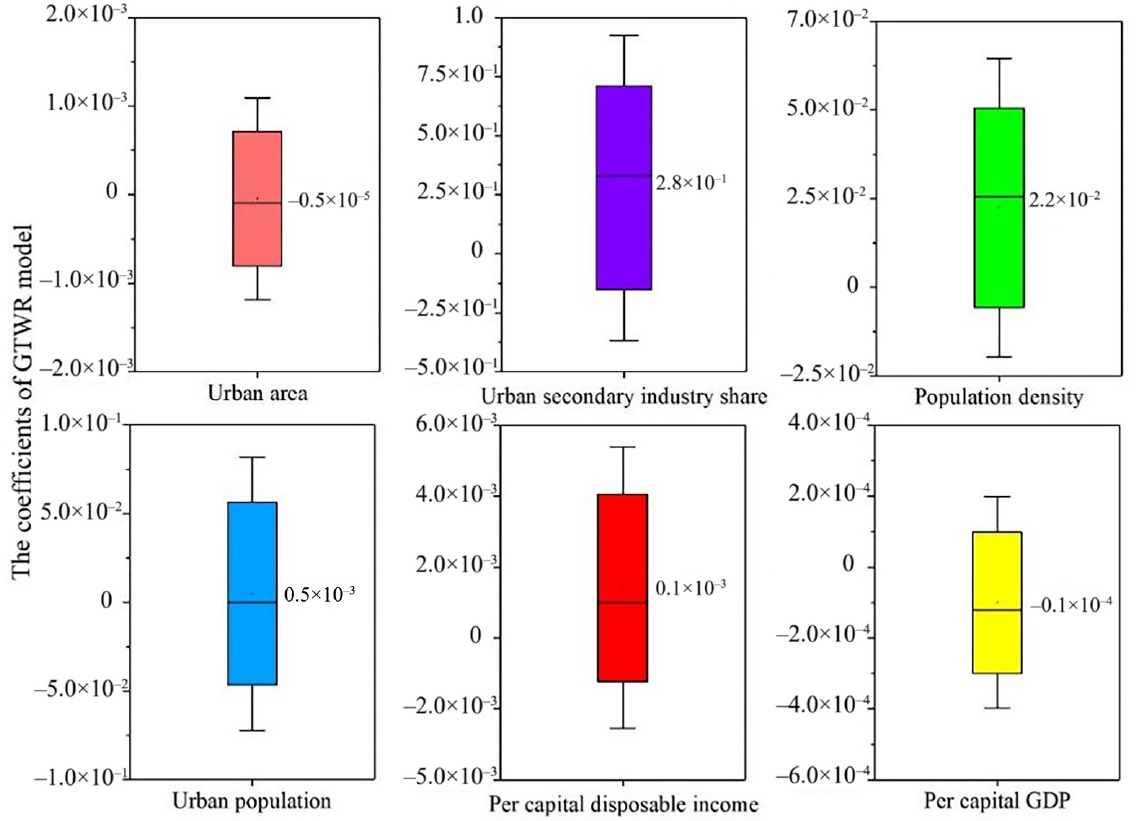
Figure 6. The estimation coefficients descriptive statistics of the GTWR model.